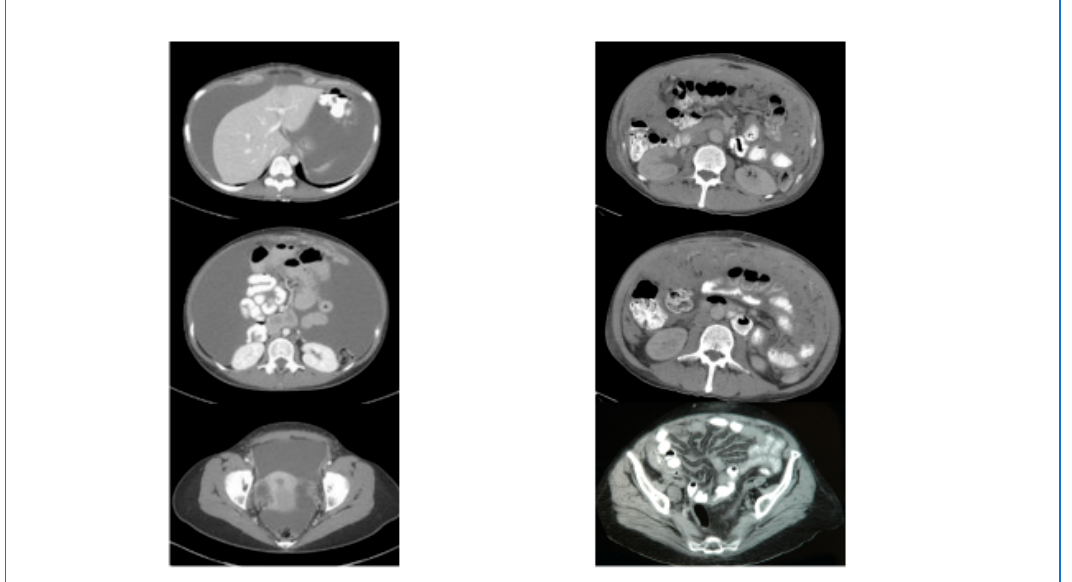
Figure 1. ( Left Panels ): Computed tomography scan of an MPM patient showing typical findings of diffuse ascites and a subtle omental mass. Note the lack of nodularity along the peritoneal surfaces. ( Right Panels ): Computed tomography scan of a patient with diffuse infiltrative MPM distributed extensively along the small bowel mesentery. This type of radiographic picture usually indicates that cytoreduction will not be successful.